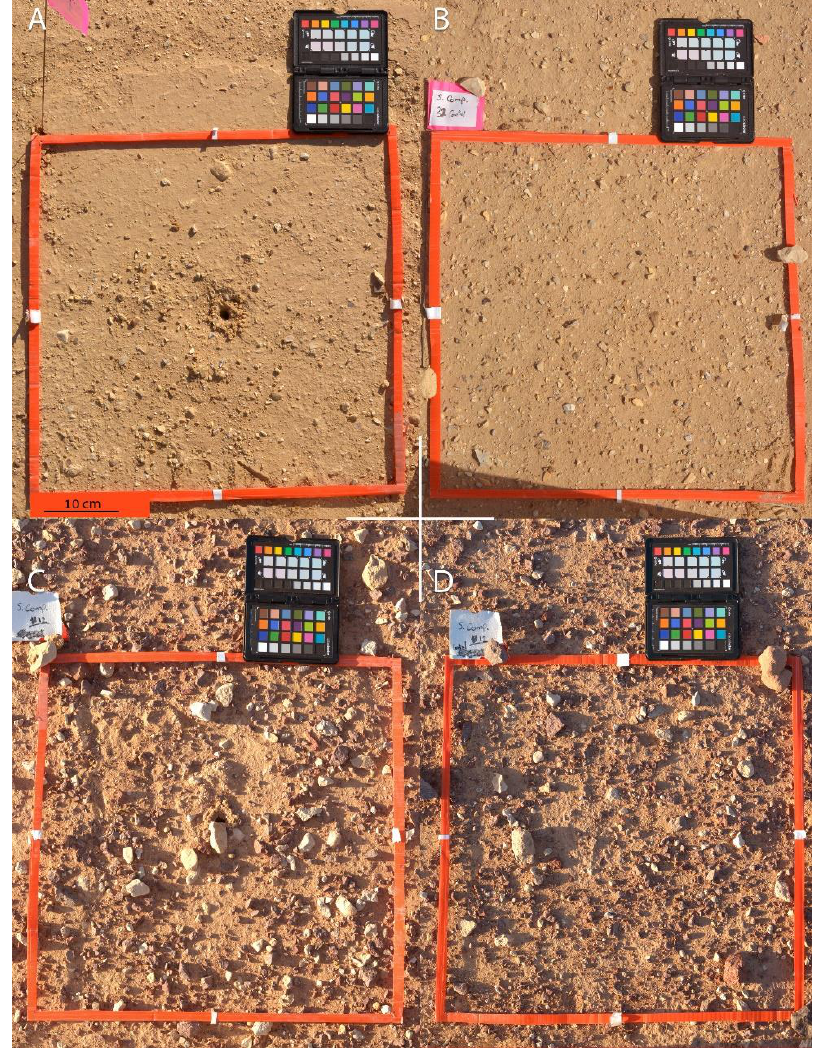
Figure 5. Quadrat survey. ( A , B ) : Quadrats in ‘Avrona nature reserve 2014 oil -spill area, ( C , D ): Figure 5. Quadrat Quadrats in ‘Avrona nature reserve 1975 oil -spill area. ( A , C ): Quadrats with Sahastata burrow (18 quadrats), ( B , D ) No-burrow quadrats (20 quadrats). Pictures: Assaf Uzan.